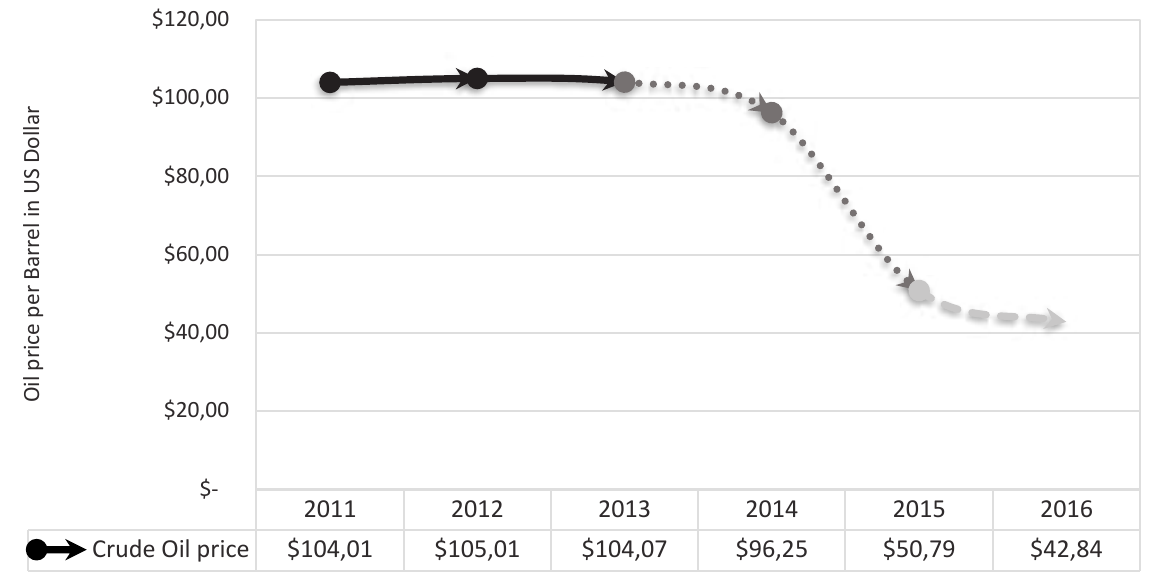
Figure 1. Crude oil price per barrel in US